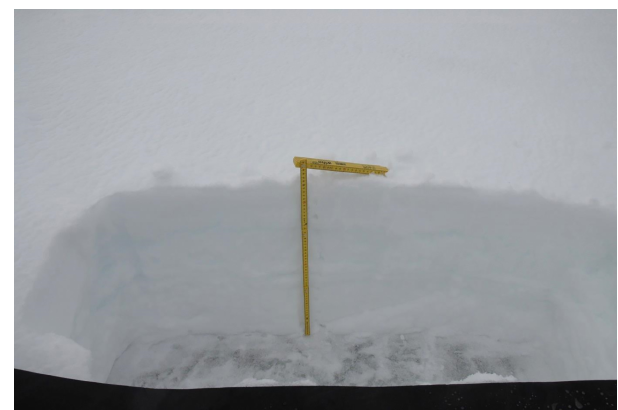
Figure E3. Snow pit, 10 May 2016. The basal ice layer is visible at the bottom of the snow layer. Two profiles were measured: one to the left and one to the right from the yellow meter stick (profile data named left and right in Table E1). Further data on temperatures, dielectric numbers and stratigraphy can be found in Table E1.